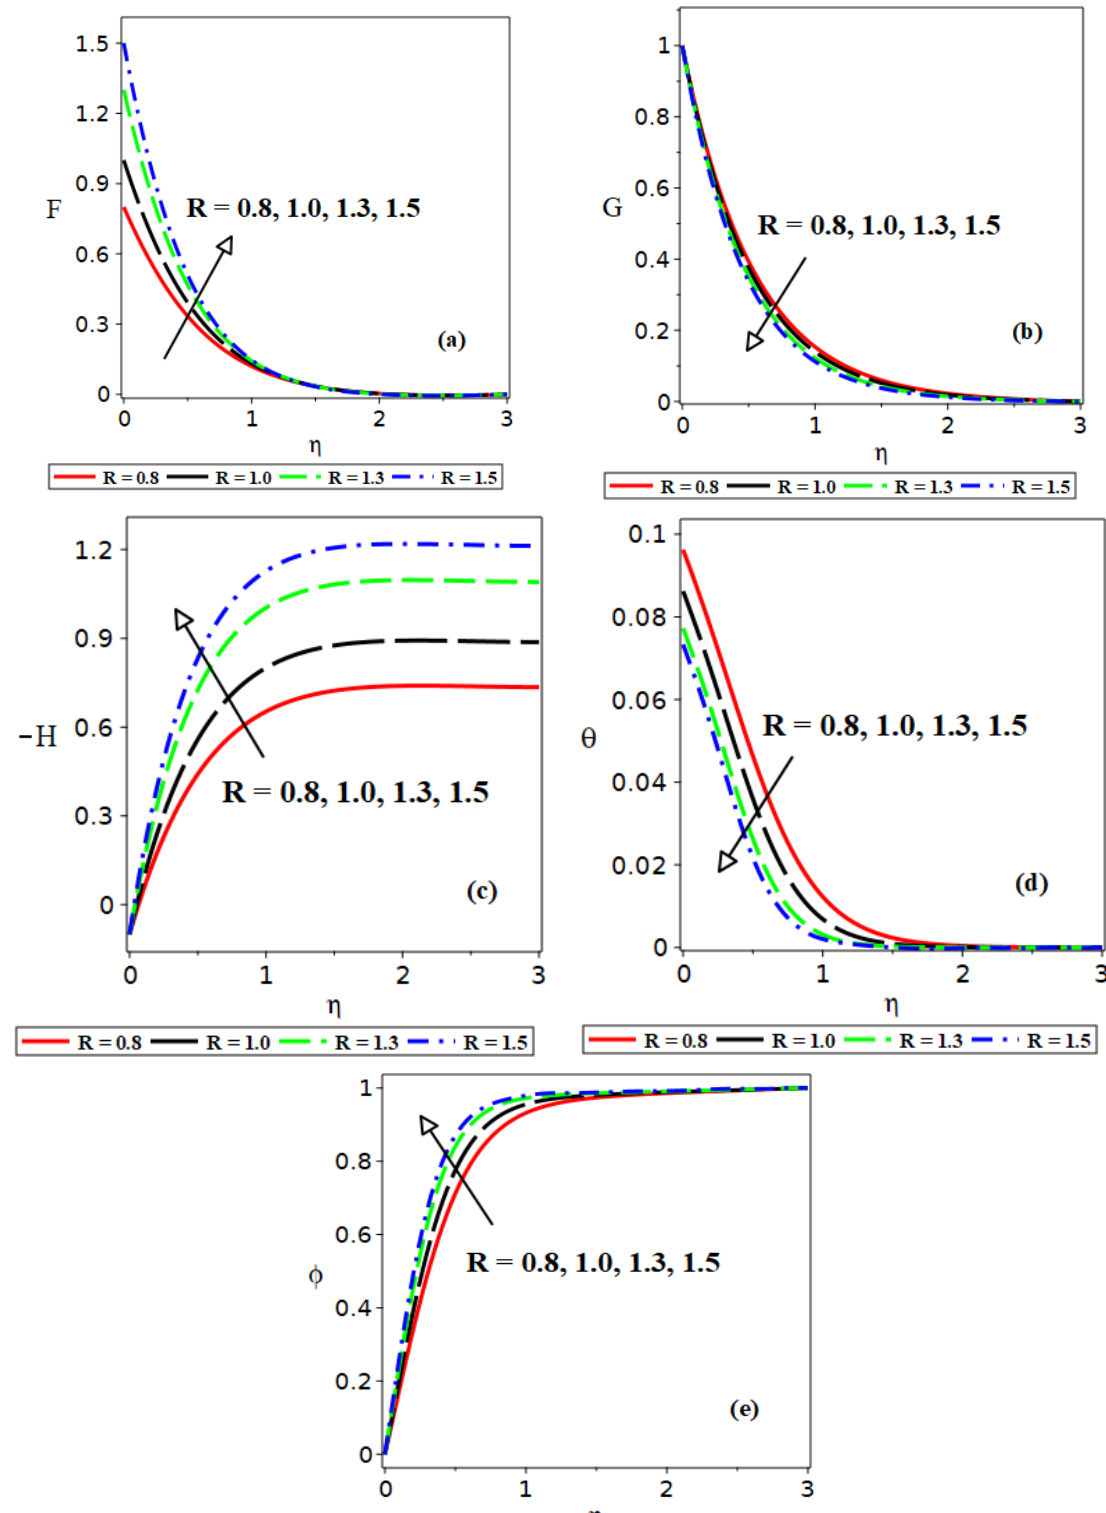
Figure 2. Effect of R on ( a ) F , ( b ) G , ( c ) {− H } , ( d ) θ , and ( e ) φ The influence of 𝛽 on the velocity, thermal, and solutal curves on a fixed magnetic (cid:2870) parameter and stretching parameter, suction parameter, and porosity parameter are shown in Figure 3a–e. It is obvious that, as the relaxation time parameter, 𝛽 powerful, the magnitude of the velocity curves decreases considerably in the radial and axial directions. In addition, an increase of 𝛽 (cid:2870) from 0.05 to 0.5 has a positive effect on the angular velocity of the liquid. Moreover, curves are plotted in order to examine the impact that 𝛽 (cid:2870) has on temperature as well as solutal distributions. It can be observed from the curves that the temperature of the liquid rises under the influence of 𝛽 (cid:2870) , while the mass concentration in the liquid reduces, as displayed in Figure 3d,e.